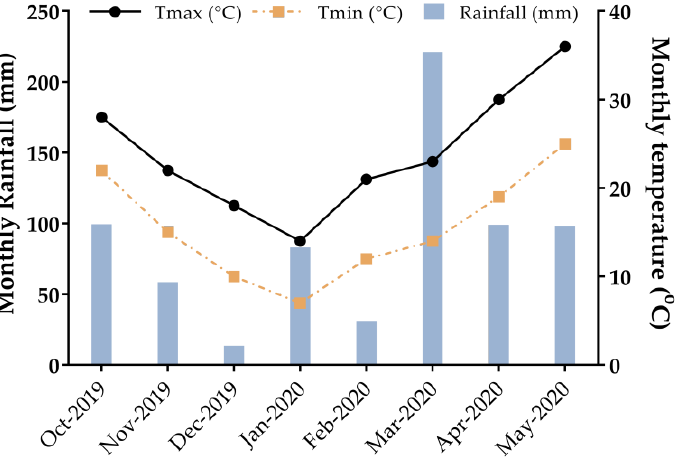
Figure 1. Maximum (Tmax) and minimum (Tmin) temperatures ( ◦ C) and rainfall (mm) at the experimental site during the growing season of